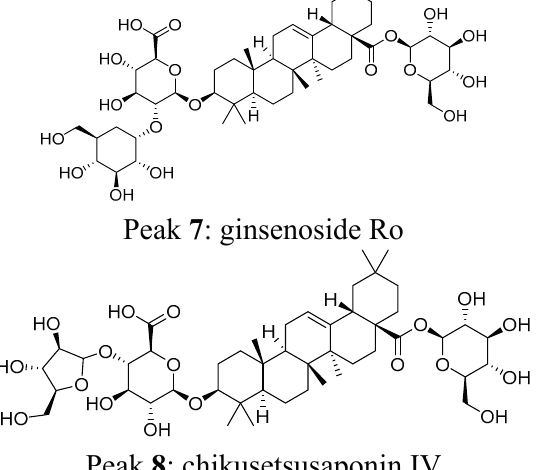
Peak 7 : ginsenoside Ro